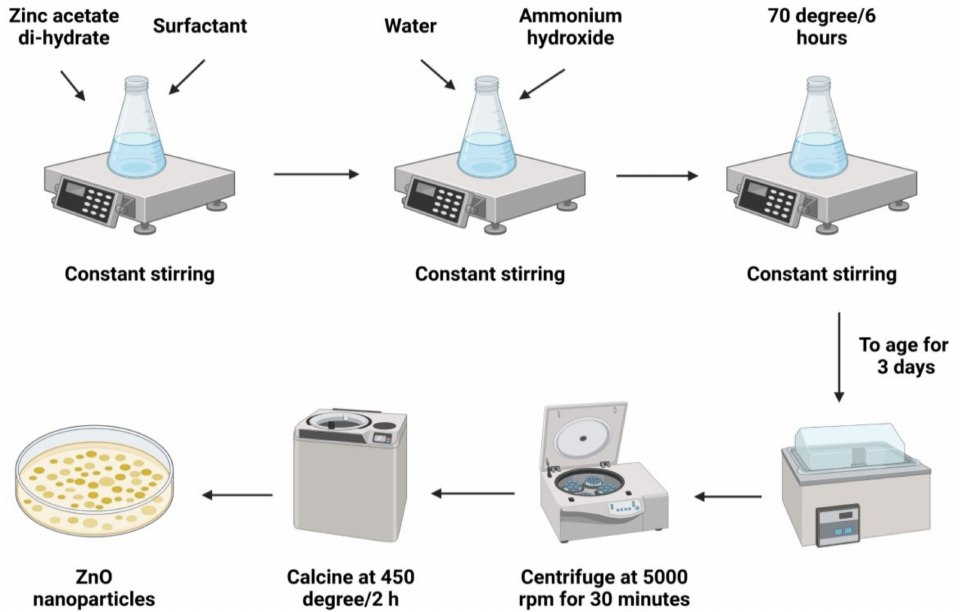
Figure 3. Diagrammatic representation of the stages required for the synthesis of metallic NPs (for example ZnO-NPs) employing the sol-gel